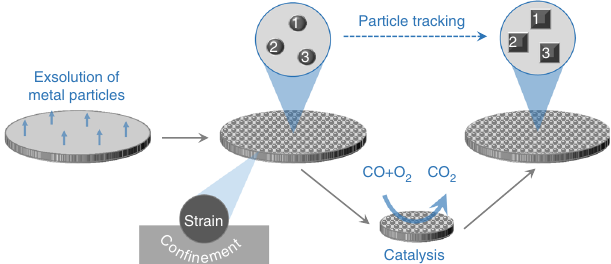
Fig. 1 Schematic of the particle tracking experiments. Initially, metal particles are exsolved on one side of a dense pellet made from the perovskite composition of choice. Representative areas of this pellet are tagged through geometrical distances to the pellet edge and by proximity to surface features such as pores or terraces (see, for example, Fig. 2f). The desired catalytic test is then carried out, the sample is removed from the reactor and again loaded in the electron microscope. The tagged areas are located and examined to identify the evolution of the particles at individual and collective level and link this to macroscopic catalytic